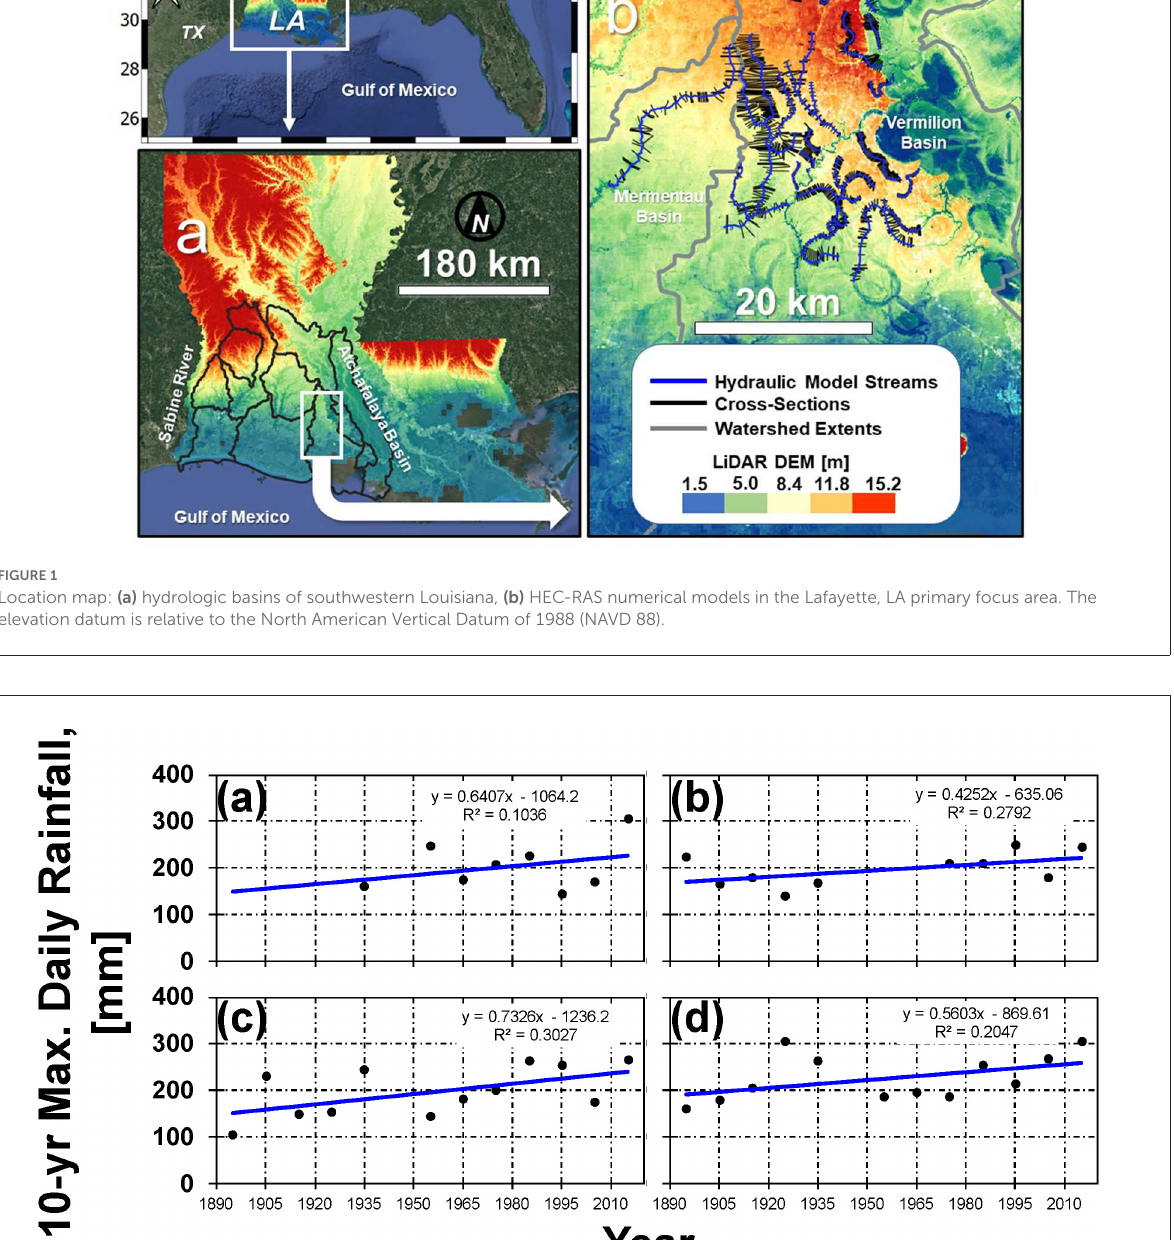
rain gauge records available within the study area. A total of four gauges were evaluated with locations at Crowley, Abbeville, Lafayette, and Grand Coteau, LA respectively.